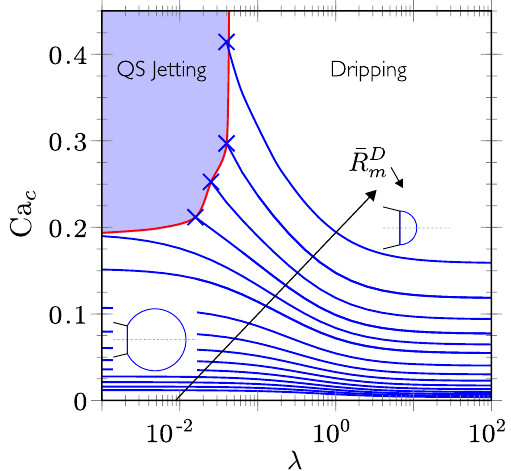
Figure 11. Influence of (cid:31) in the quasi-static dripping regime on the value of Ca c necessary to produce a drop D from a meniscus equivalent radius ¯ R m (blue lines). The red curve corresponds to the dripping-jetting transition for Ca ∗ c . The geometry of couple 1 has been used. The two sketches show the equivalent spherical cap for Ca c = 0 for large and small ¯ L , i.e. large and small